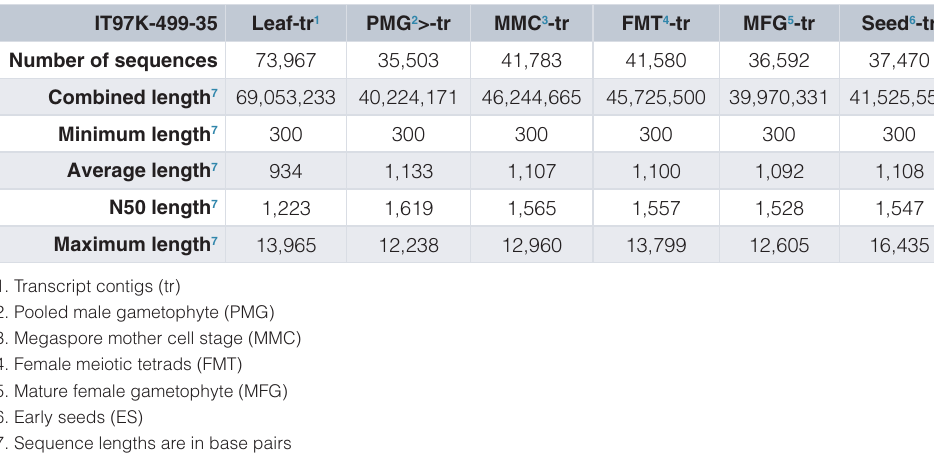
Table 6. Details of assembled tissue-specific polyA RNA sequence sets from IT97K-499-35. Assembled contigs of less than 300 base pairs were excluded in this analysis.